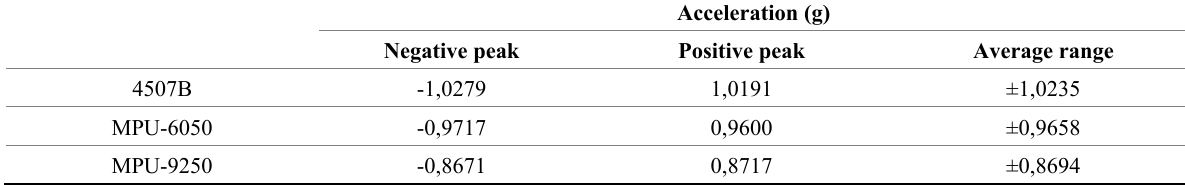
Table 3. Absolute acceleration peaks using the calibrator.